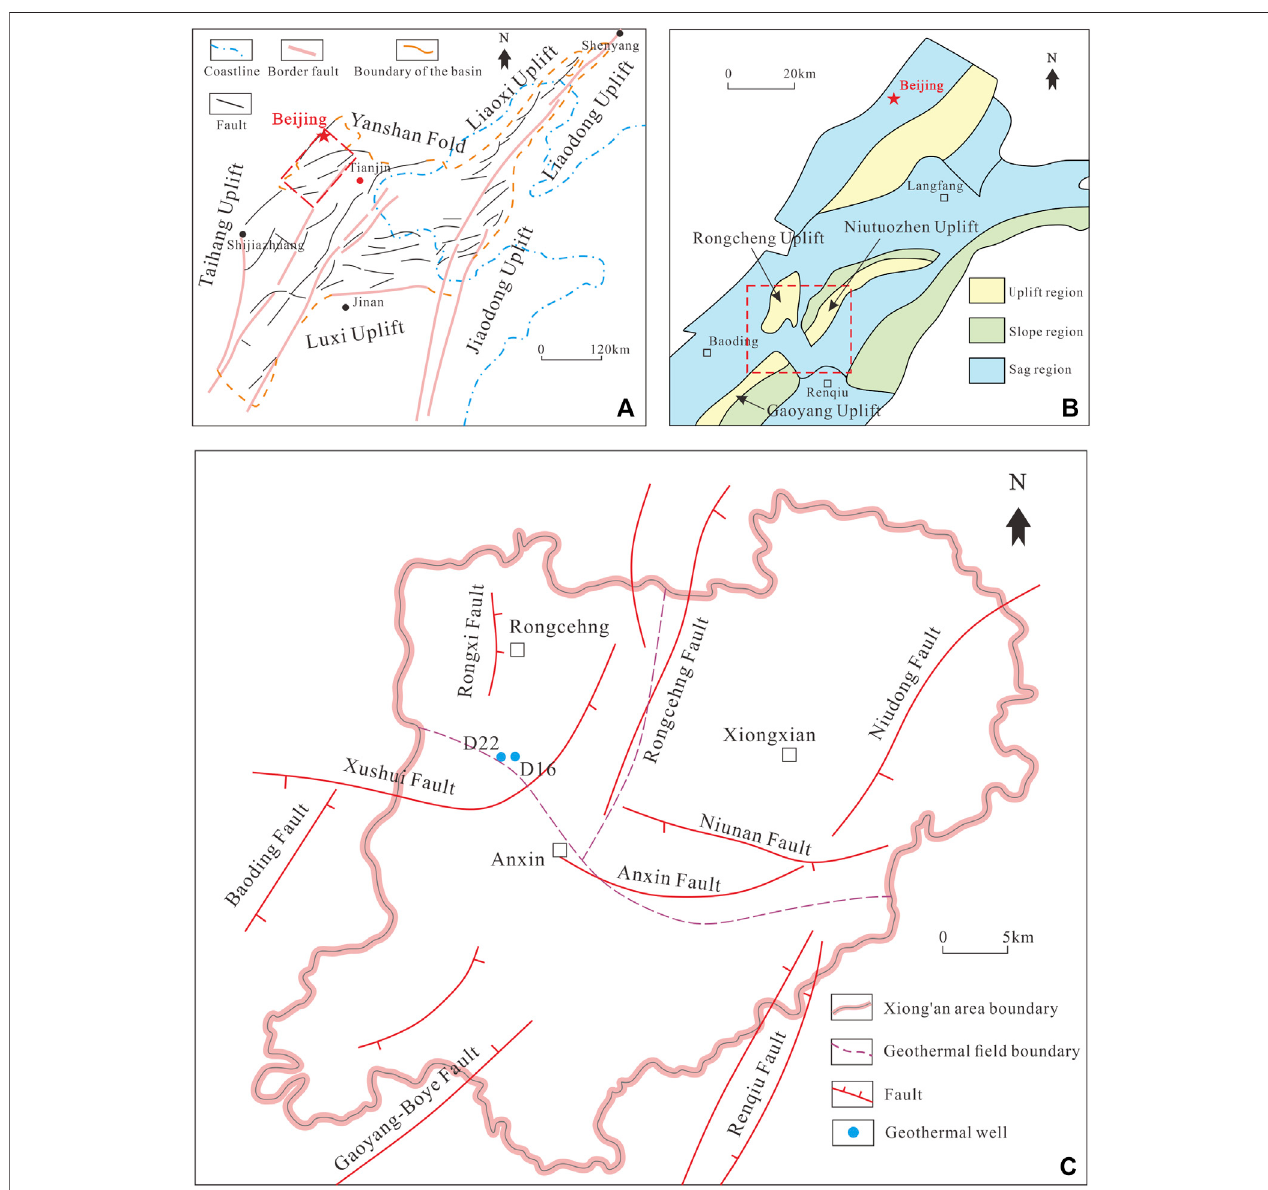
FIGURE 1 | (A) Basic tectonic map of the Bohai Bay Basin; (B) Basic tectonic map of the Jizhong depression (from He et al., 2018); (C) Distributions of the major faults, geothermal fi elds, and boreholes in the Xiongan New Area.